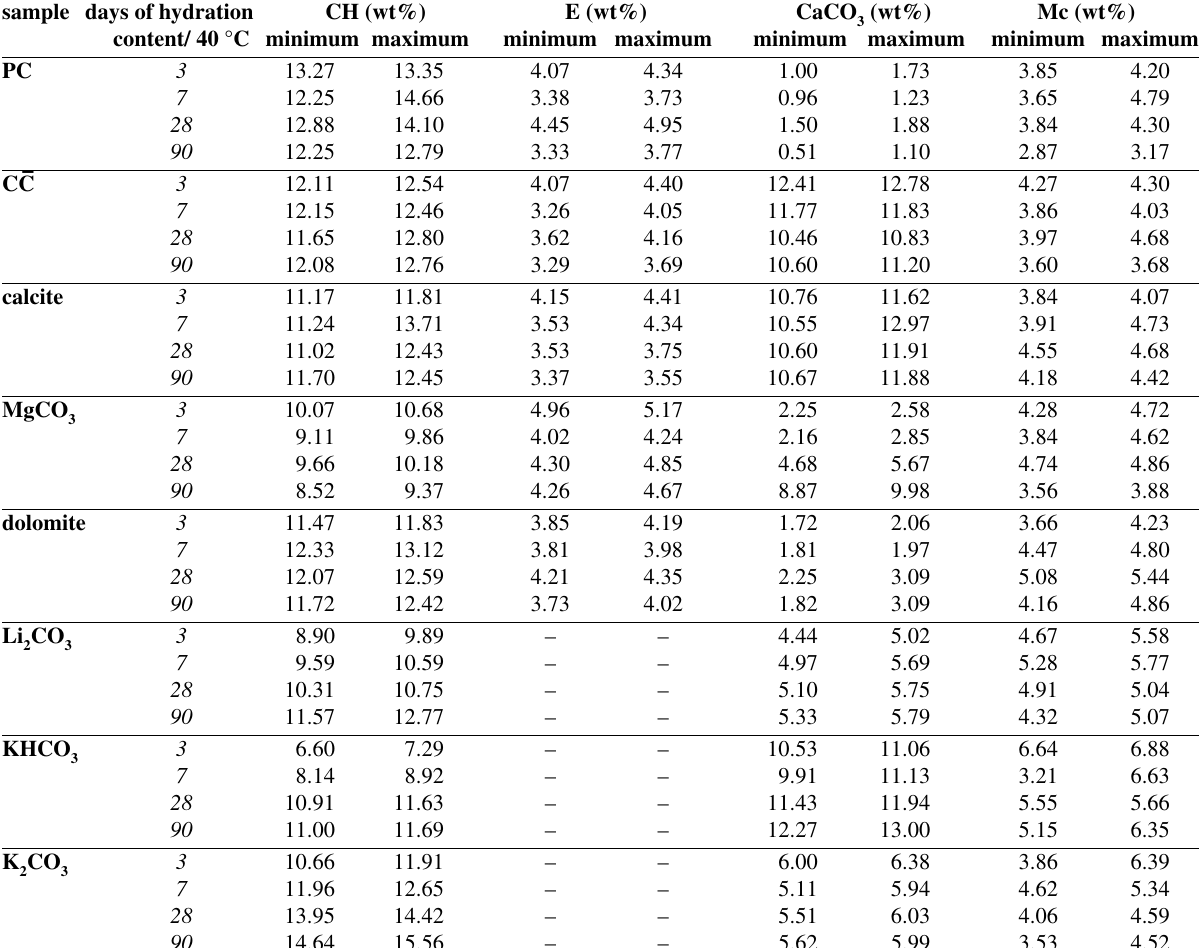
Table 5. The minimum and maximum contents of hydration products in relation to hydration time and 40 °C. sample days of